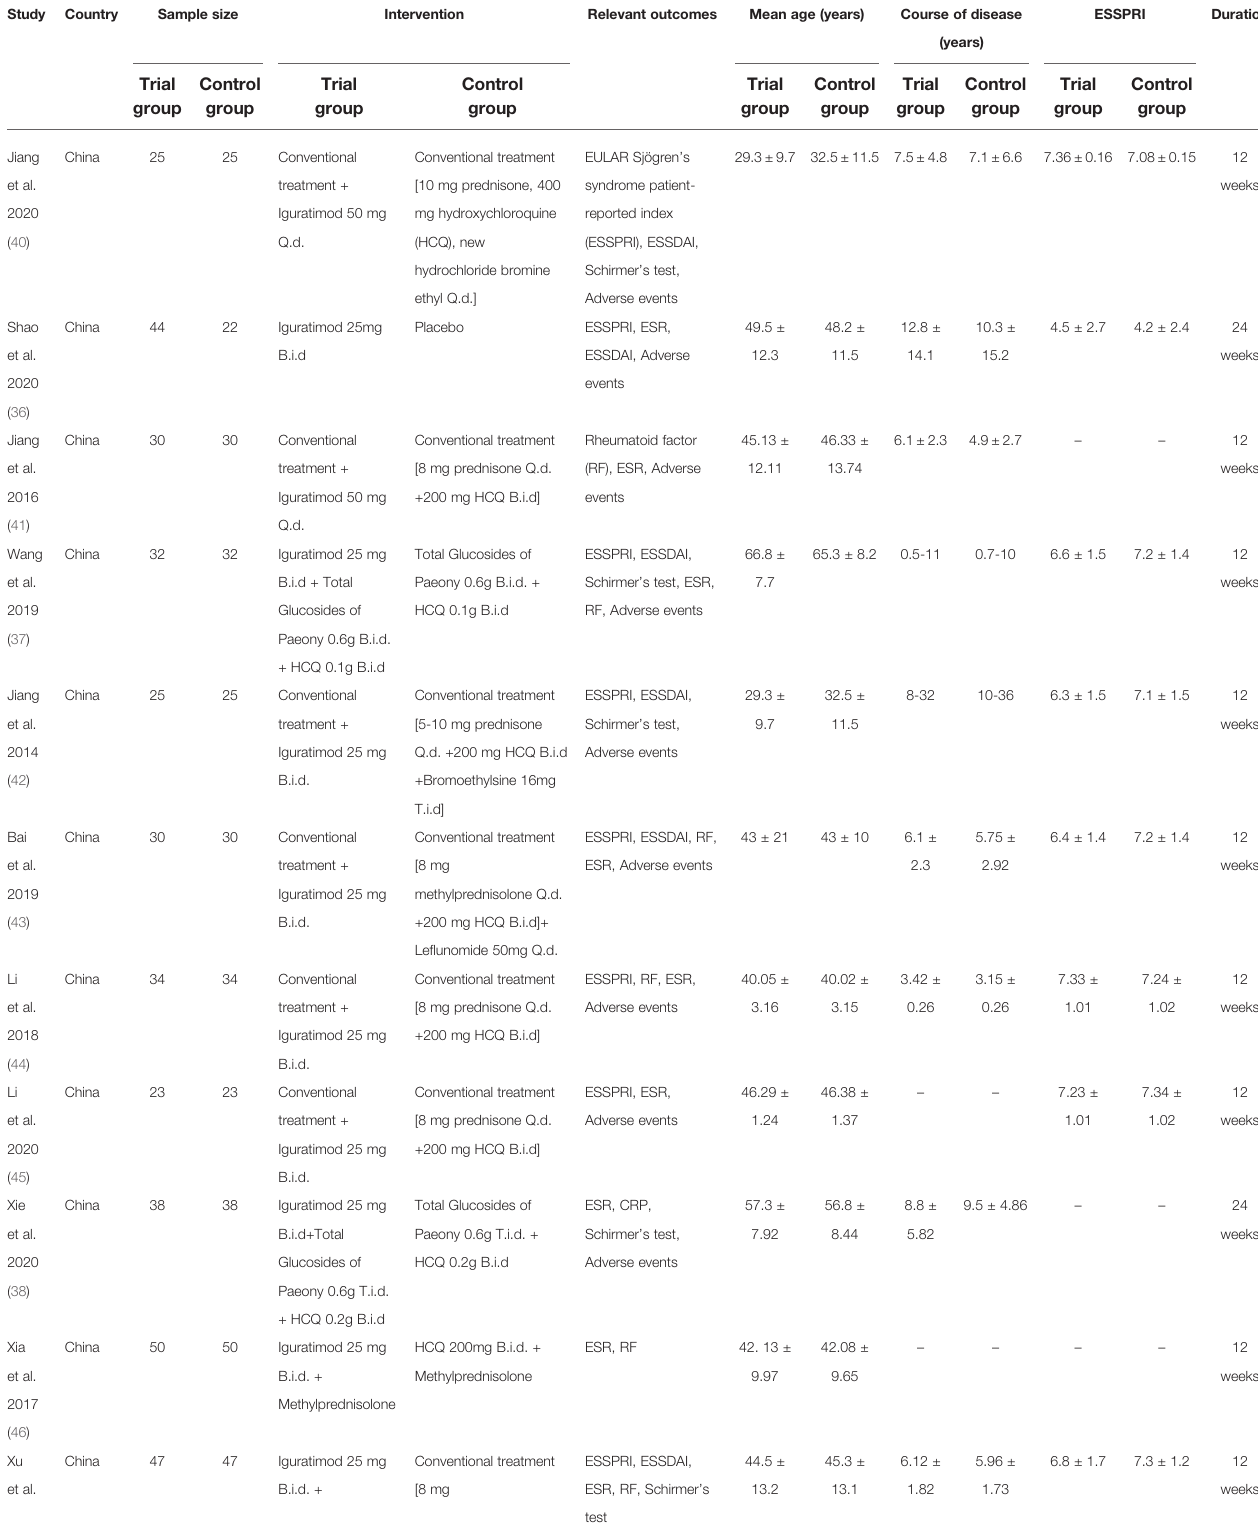
TABLE 1 | The characteristics of the included studies. Study